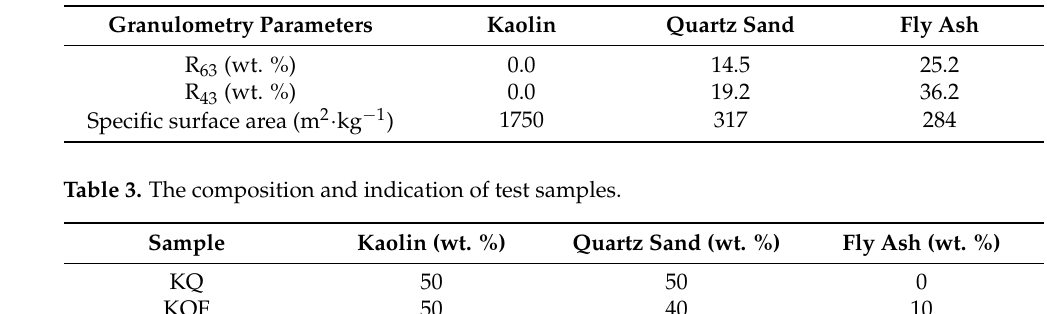
Table 2. The granulometry of used materials—residue of grains on 63 µ m (R 63 ) and 43 µ m (R 43 ) sieves, specific surface area.